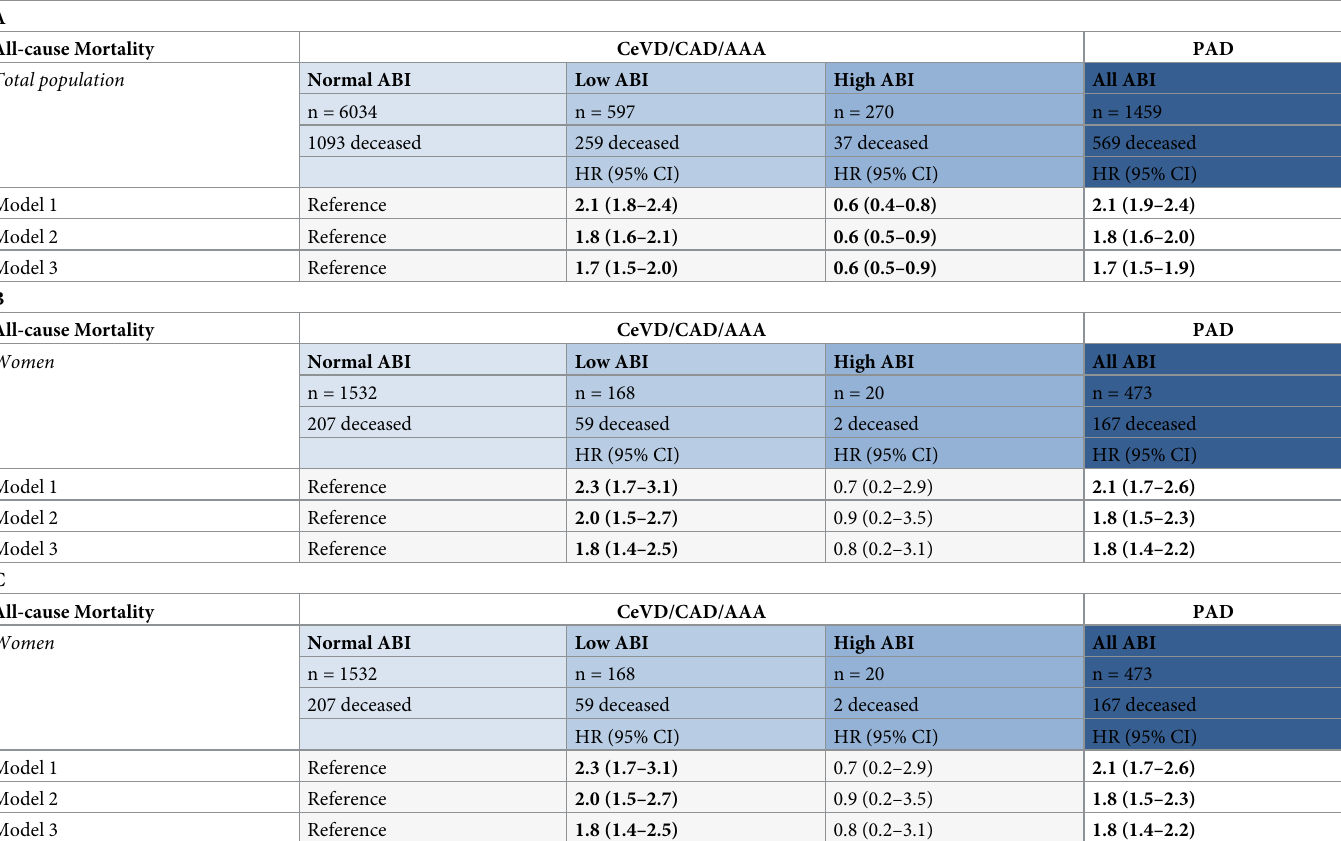
Table 5. The association between screen-detected abnormal ABI scores & manifest PAD and all-cause mortality.